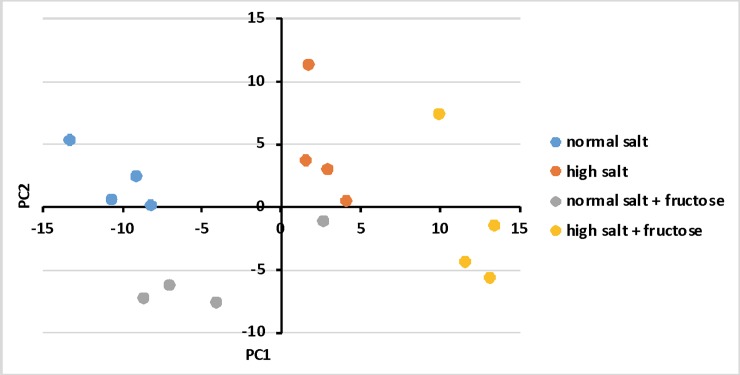
Principal component analysis (PCA) to distinguish among the 4 groups of animal treatments (±fructose on 2 different base diets).PCA analysis was carried out with the expression data of the 100 top fructose-specific plus 100 top diet-specific Affymetrix TranscriptClusterIDs, i.e., genes regardless of whether they are annotated or not.